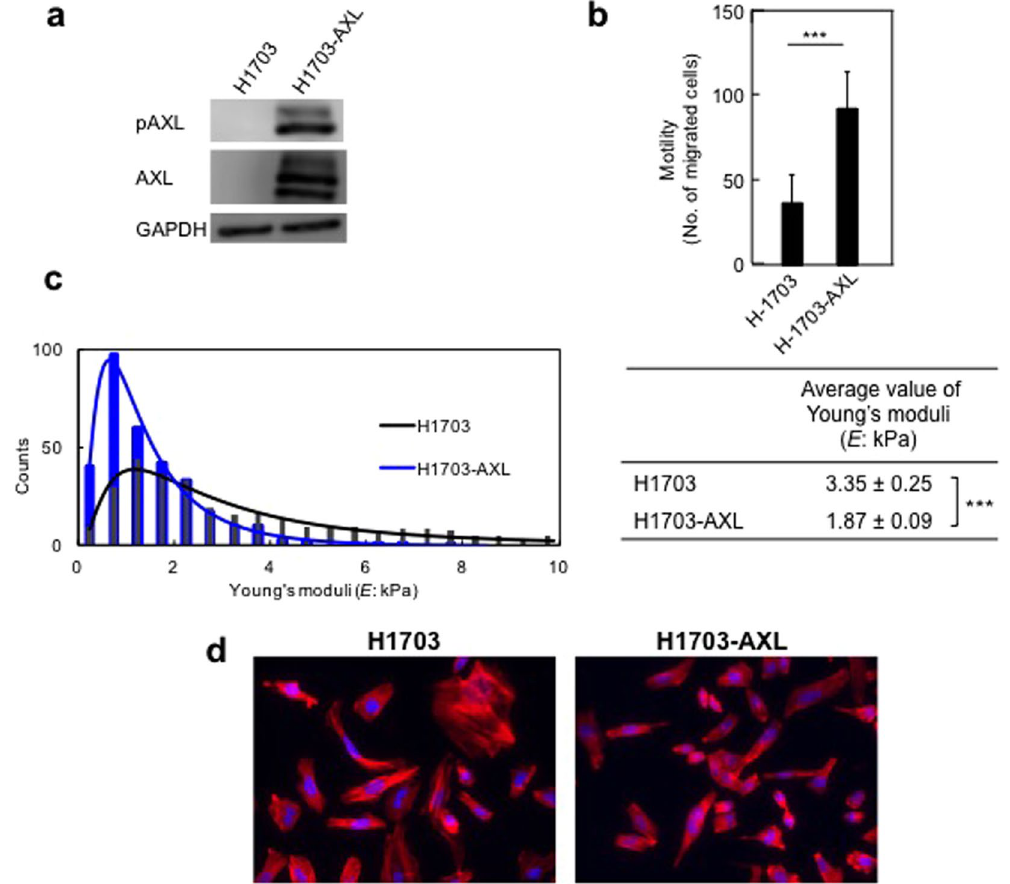
Figure 5. Exogenous expression of AXL gene increases motility, and reduces stiffness, formation of actin stress fibres and phosphorylated focal adhesion kinase in H1703 cells. ( a ) Western blot analysis of H1703 cells and the H1703-AXL cell line that stably expresses AXL-GFP. GADPH was used as loading control. ( b ) Cell motility assays of H1703 cells and the H1703-AXL cell line that stably expresses AXL-GFP. Average percentage of migrated cells in three independent experiments. Mean ± s.d. Number of migrated cells in non-treated cells was set as 100%. *** p < 0.001. ( c ) Left, Young’s moduli of 60 H1703 and H1703-AXL cells were determined using AFM. Black line indicates the log-normal fitting curve for H1703 cells, and blue line is the curve for H1703- AXL cells. Right, average values of Young’s moduli were obtained from log-normal fitting curves. *** p < 0.001. ( d ) Actin stress fibres formation (red) in H1703 and H1703-AXL cells. DAPI (blue) indicates